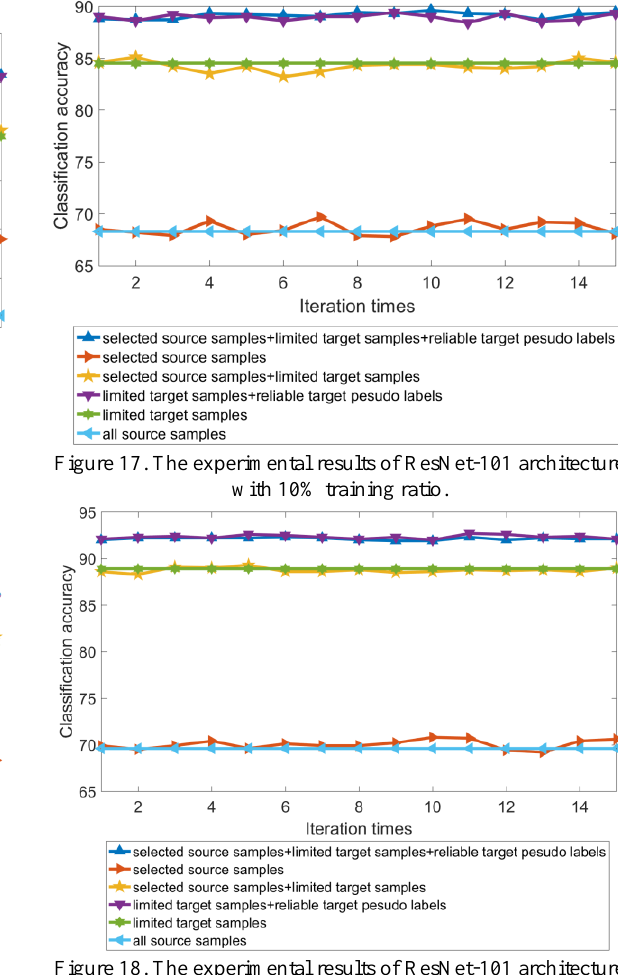
Figure 13. The experimental results of ResNet-18 architecture with 5% training ratio.